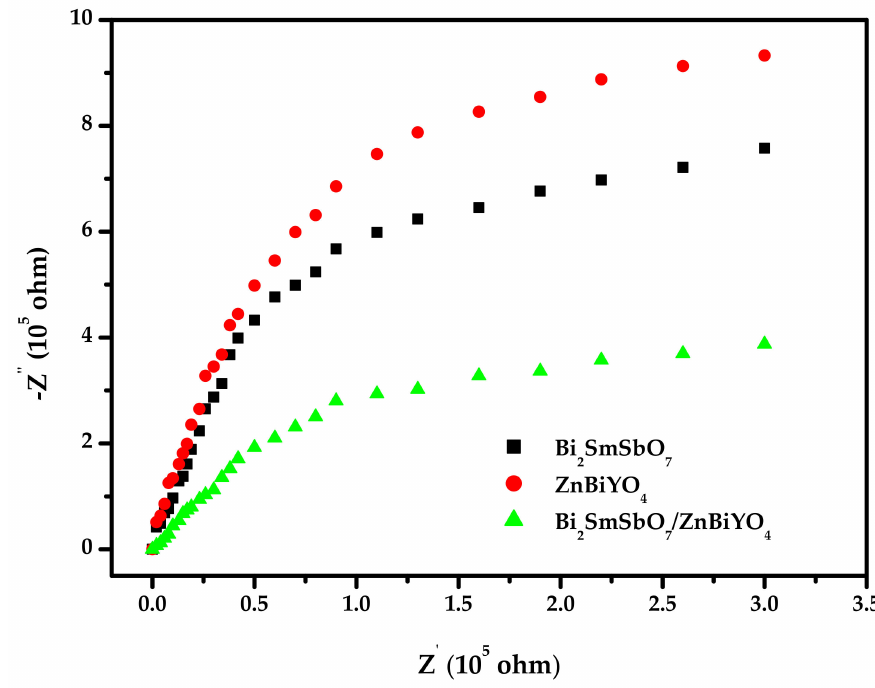
Figure 20. Nyquist impedance plots of Bi 2 SmSbO 7 /ZnBiYO 4 heterojunction photocatalyst or Bi 2 SmSbO 7 photocatalyst or ZnBiYO 4